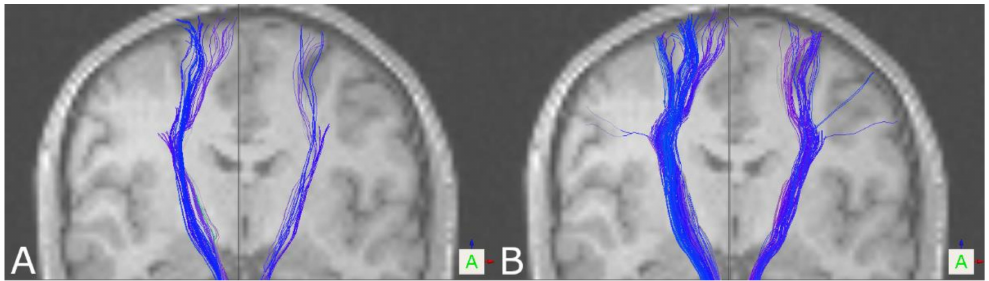
Figure 1. Tractography results of the CST for a healthy volunteer based on DTI ( A ) and DKI ( B ), showing a broader fanning within the motor cortex, also sparsely connecting to the lateral part of the motor cortex (coronal view).